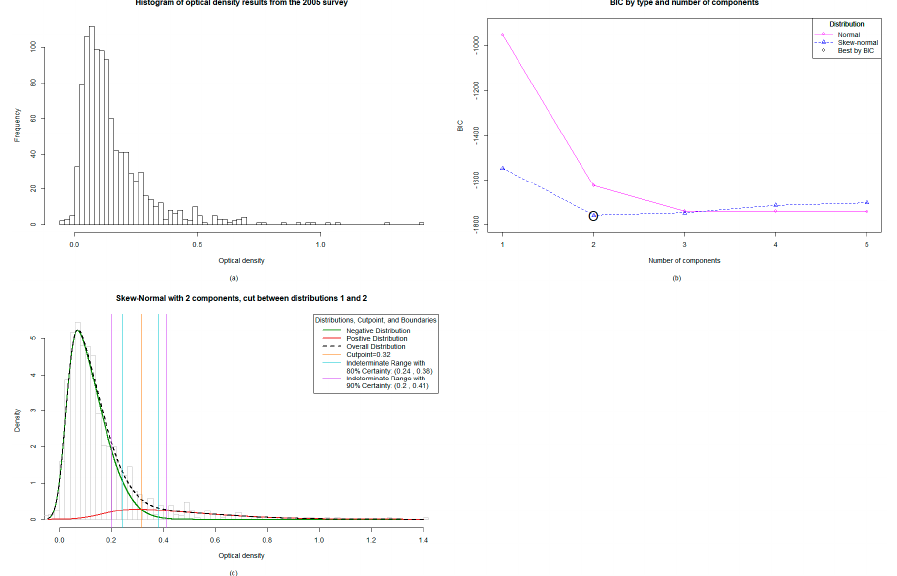
Figure 1. Mixture modelling analysis for the 2005 Transmission Assessment Survey/C Survey in Vanuatu: ( a ) The distribution of data from the 1027 samples was significantly right skewed, ( b ) The algorithm identified the two-component skew-normal model as optimal, ( c ) When analyzed, the two-component model showed an absolute cut-off value of 0.316 and an indeterminate range with 80% certainty falling between 0.244 and 0.38.